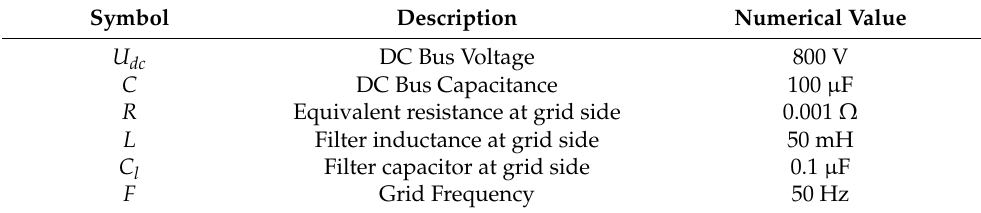
Table 2. Parameters of the